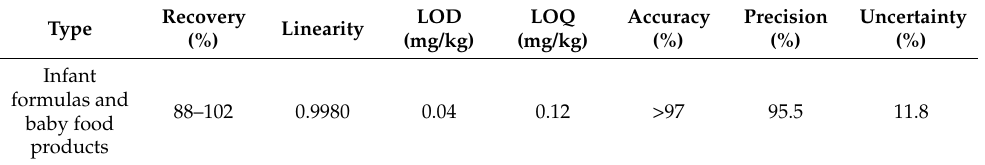
Table 2. Sensitivity, recovery, and precision indicators for Al in infant formulas and baby food